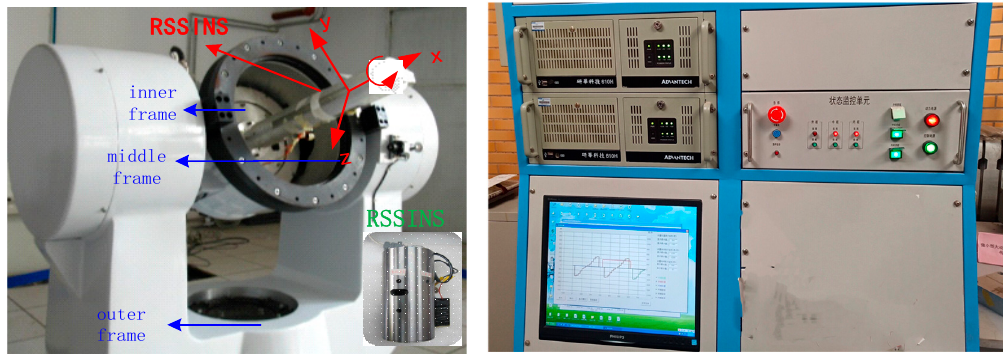
Figure 10. Rotating strapdown inertial navigation system (RSSINS) installation on tri-axial rotation table and a console.